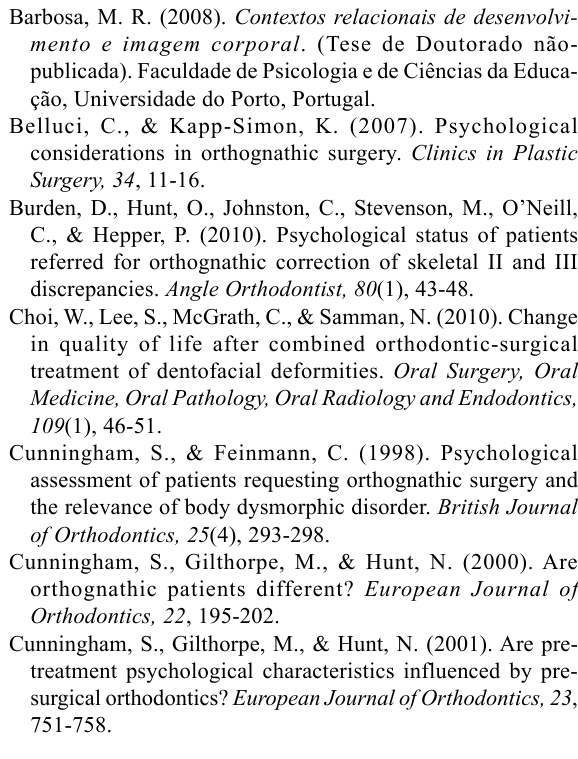
Barbosa, M. R. (2008). Contextos relacionais de desenvolvi- mento e imagem corporal . (Tese de Doutorado não- publicada). Faculdade de Psicologia e de Ciências da Educa- ção, Universidade do Porto,